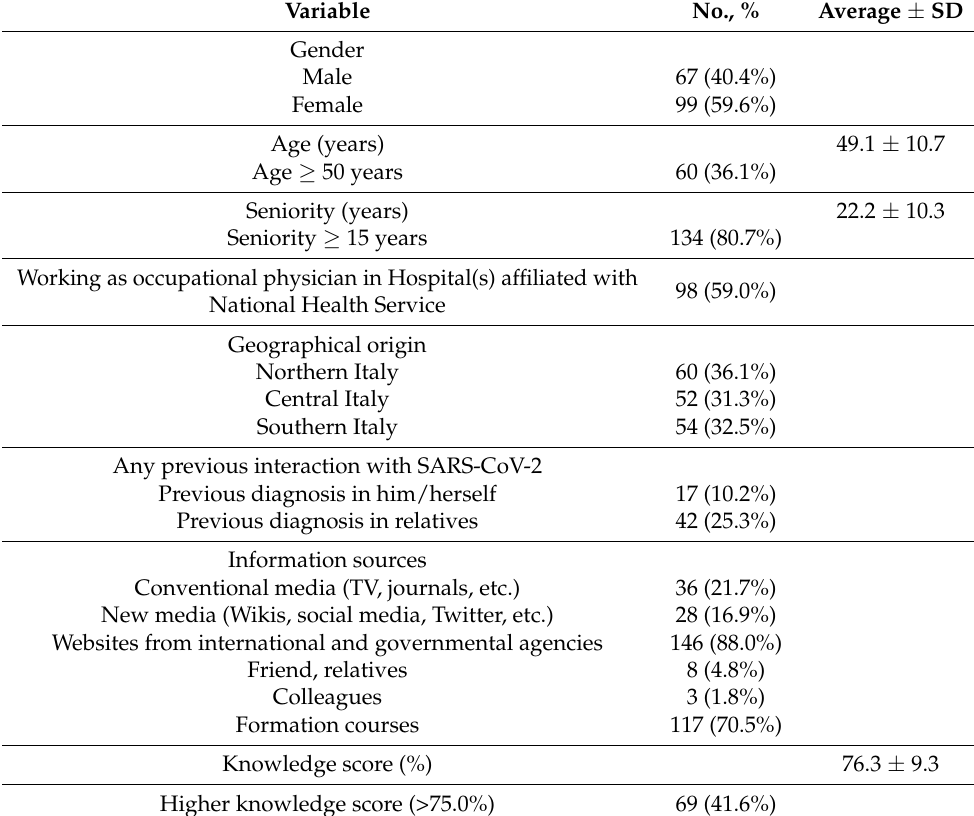
Table 1. General characteristics of 166 occupational physicians participating in the survey (January